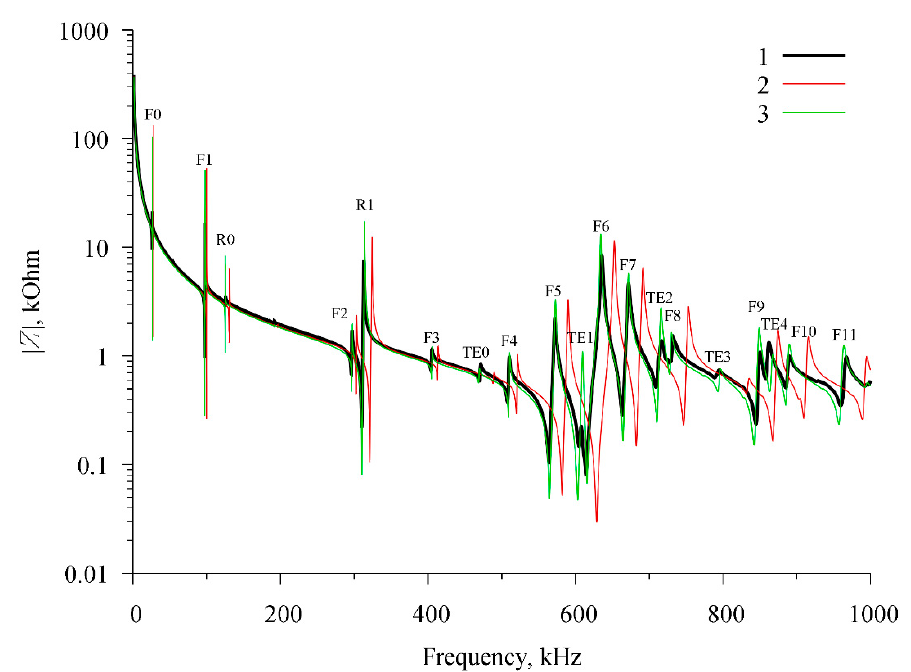
Figure 5. Frequency dependence of the modulus of electrical impedance of a radial electric field excited resonator. 1—experimental data; 2—calculation using the reference values of material constants; and 3—calculation using the refined material constants (stage 2).